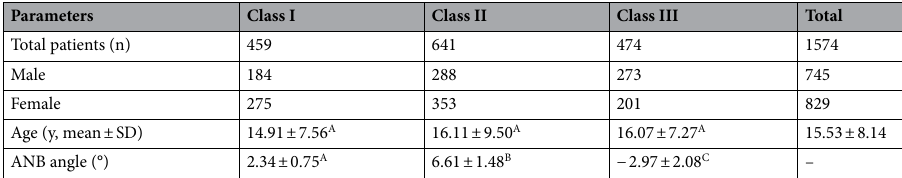
Table 1. Descriptive statistics of the sample in this study. Values in the same row followed by the same letters are not significantly different at p < 0.05 according to a one-way analysis of variance with the post hoc Tukey’s test.